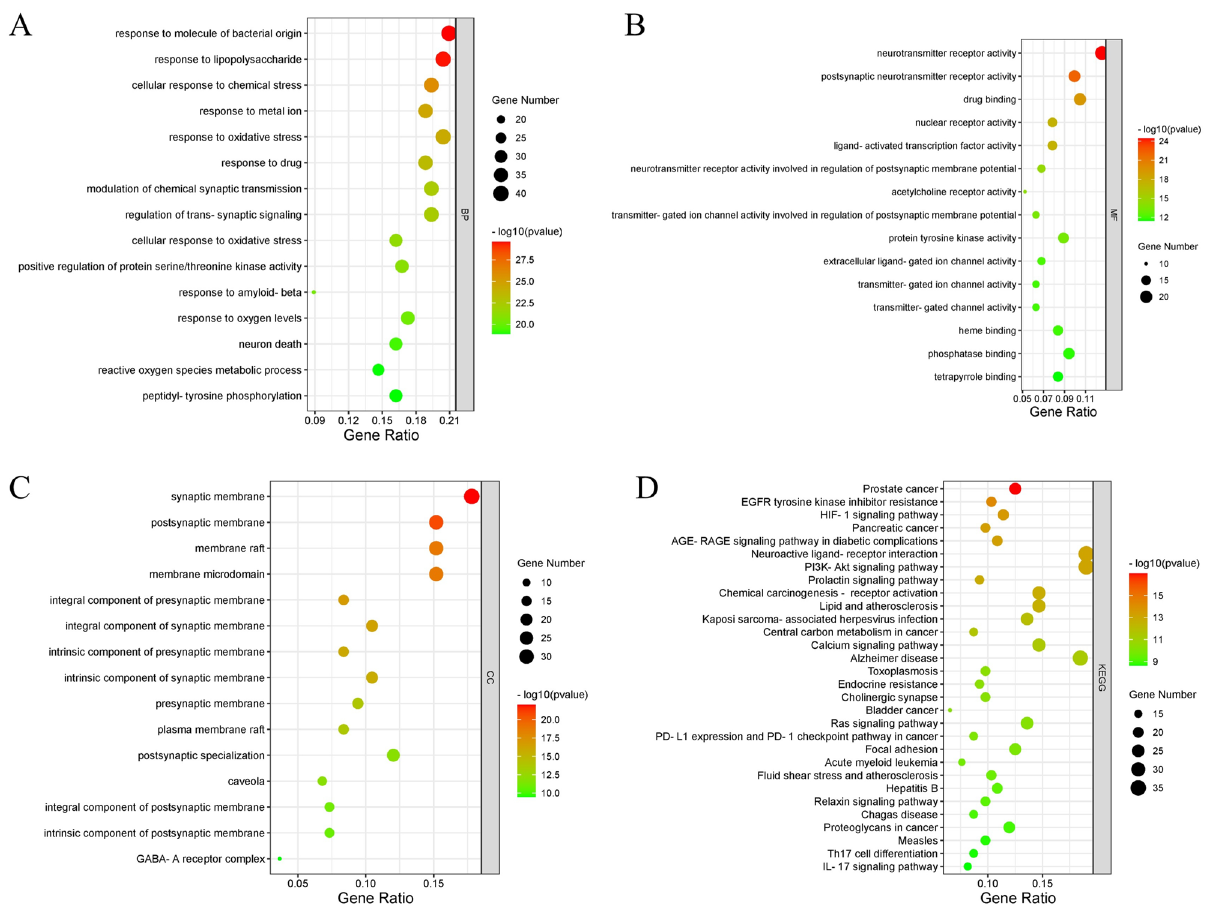
Figure 4. GO and KEGG pathway enrichment analysis of cinnamon and AD intersection targets. ( A - C ) GO-BP, MF, CC analyses respectively. ( D ) KEGG